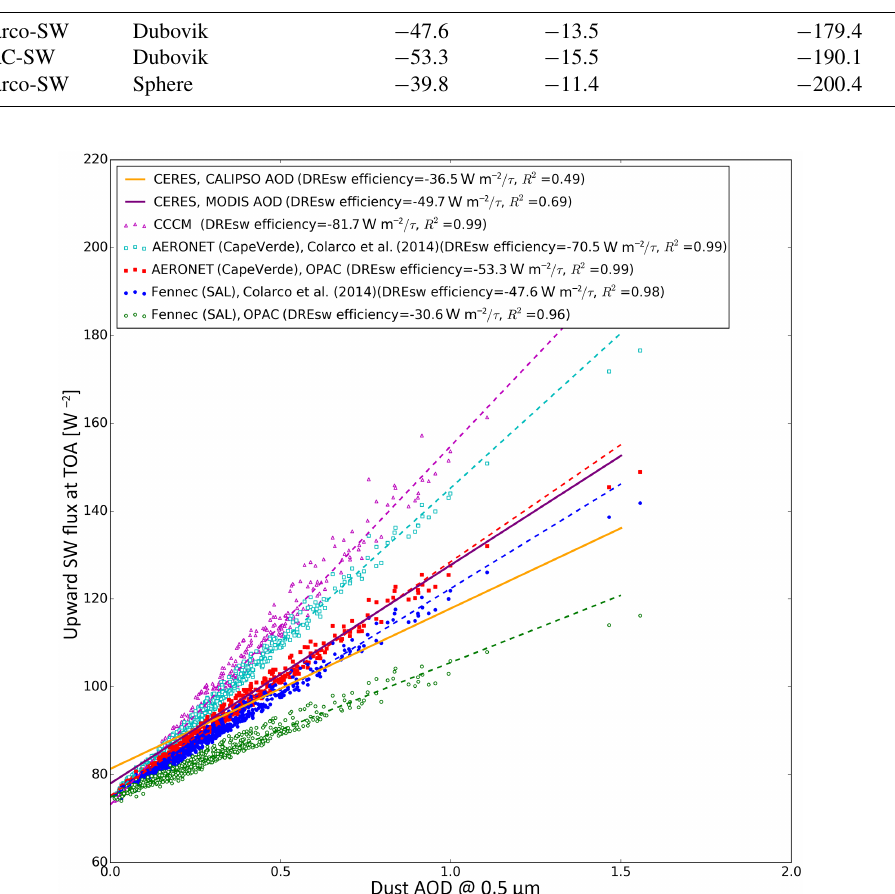
Figure 8. The four sets of simulated TOA upward SW fluxes as a function of the input AOD at 0.5µm. For comparison purposes, the DRE SW efficiency regression results based on observations in Fig. 5, as well as the results reported in the CCCM product, are also plotted.